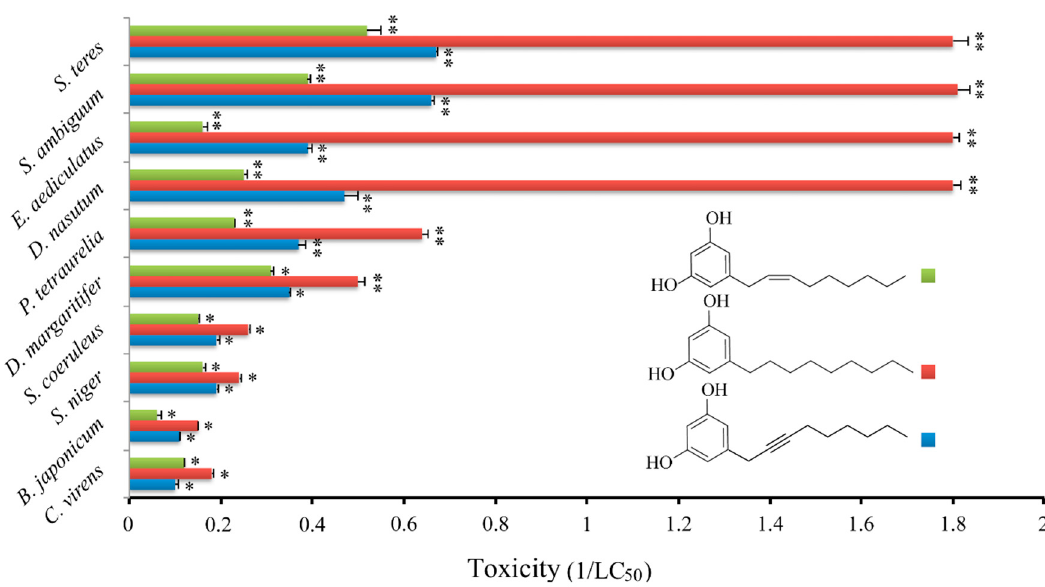
Figure 3. Cytotoxic effect of climacostol and its alkyl and alkynyl derivatives on ten ciliate species. Cell viability was assessed after 24 h, and each bar represents the mean (±SE) of 3 independent experiments. * p < 0.05 and ** p < 0.001. Original data from [24].